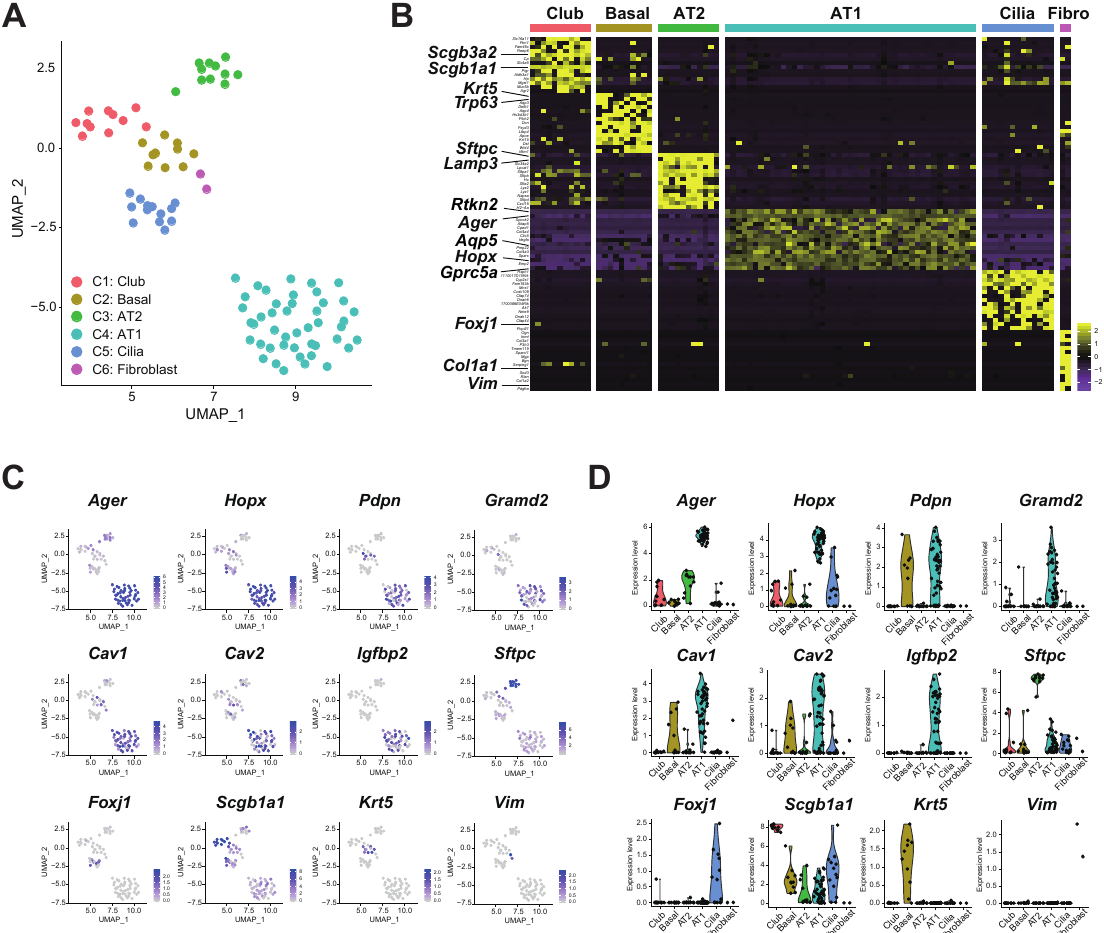
Figure 2. Clustering of 92 tdTomato-positive cells in ACID;R26tdTomato mice. ( A ) Unsupervised UMAP divided 92 cells into 6 clusters (C1–C6). Expression level (C and D) represents absolute read count. ( B ) Heatmap with 10–15 markers representative of each cell type. Yellow and purple colors indicate high and low expression, respectively. ( C ) UMAP plots with known cell type-specific marker genes. AT1 cells ( Ager , Hopx , Pdpn , Igfbp2 , Cav1 , Cav2 and Gramd2 ), AT2 cells ( Sftpc ), club cells ( Scgb1a1 ), basal cells ( Krt5 ), ciliated cells ( Foxj1 ) and fibroblasts ( Vim ). Blue and grey indicate high and low expression, respectively. ( D ) Violin plot with the same marker genes as in